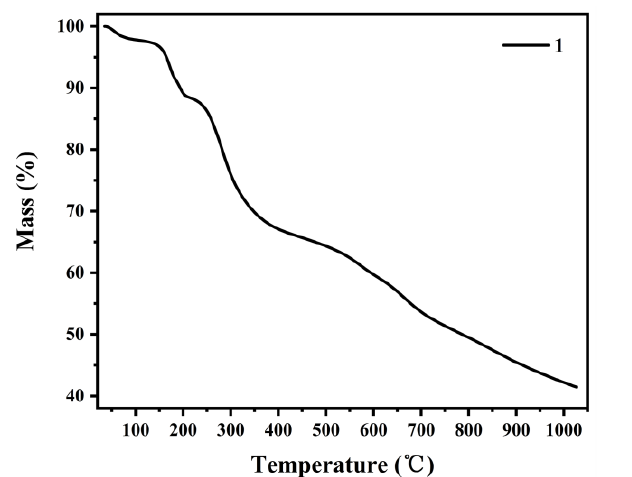
Figure 6. TG curve of complex 1 .